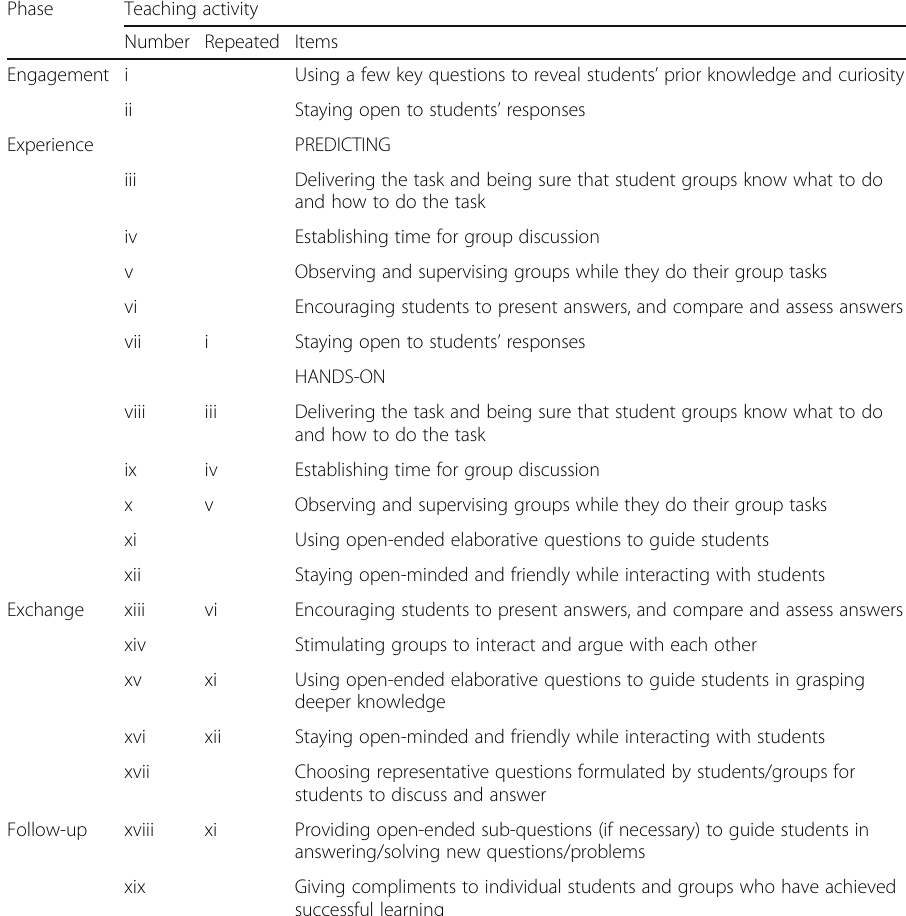
Table 5 The teaching activities proposed by the CHC teachers to apply to the designed